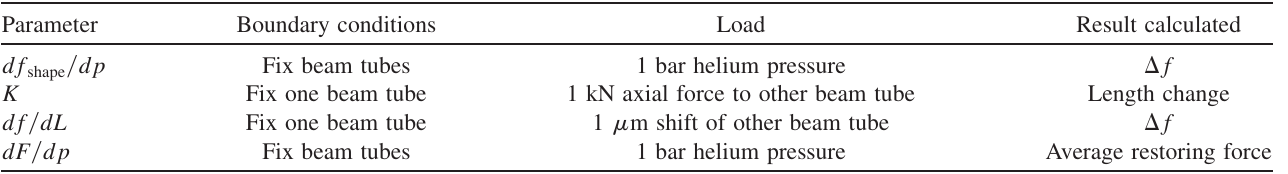
TABLE II. Simulations used to find parameters from the df=dp model.